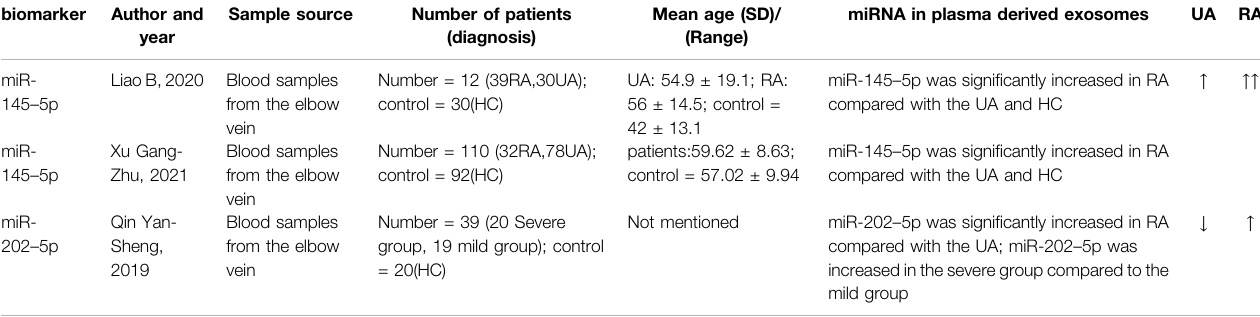
TABLE 2 | Summary of circulating exosome-derived miRNA in predicting rupture of